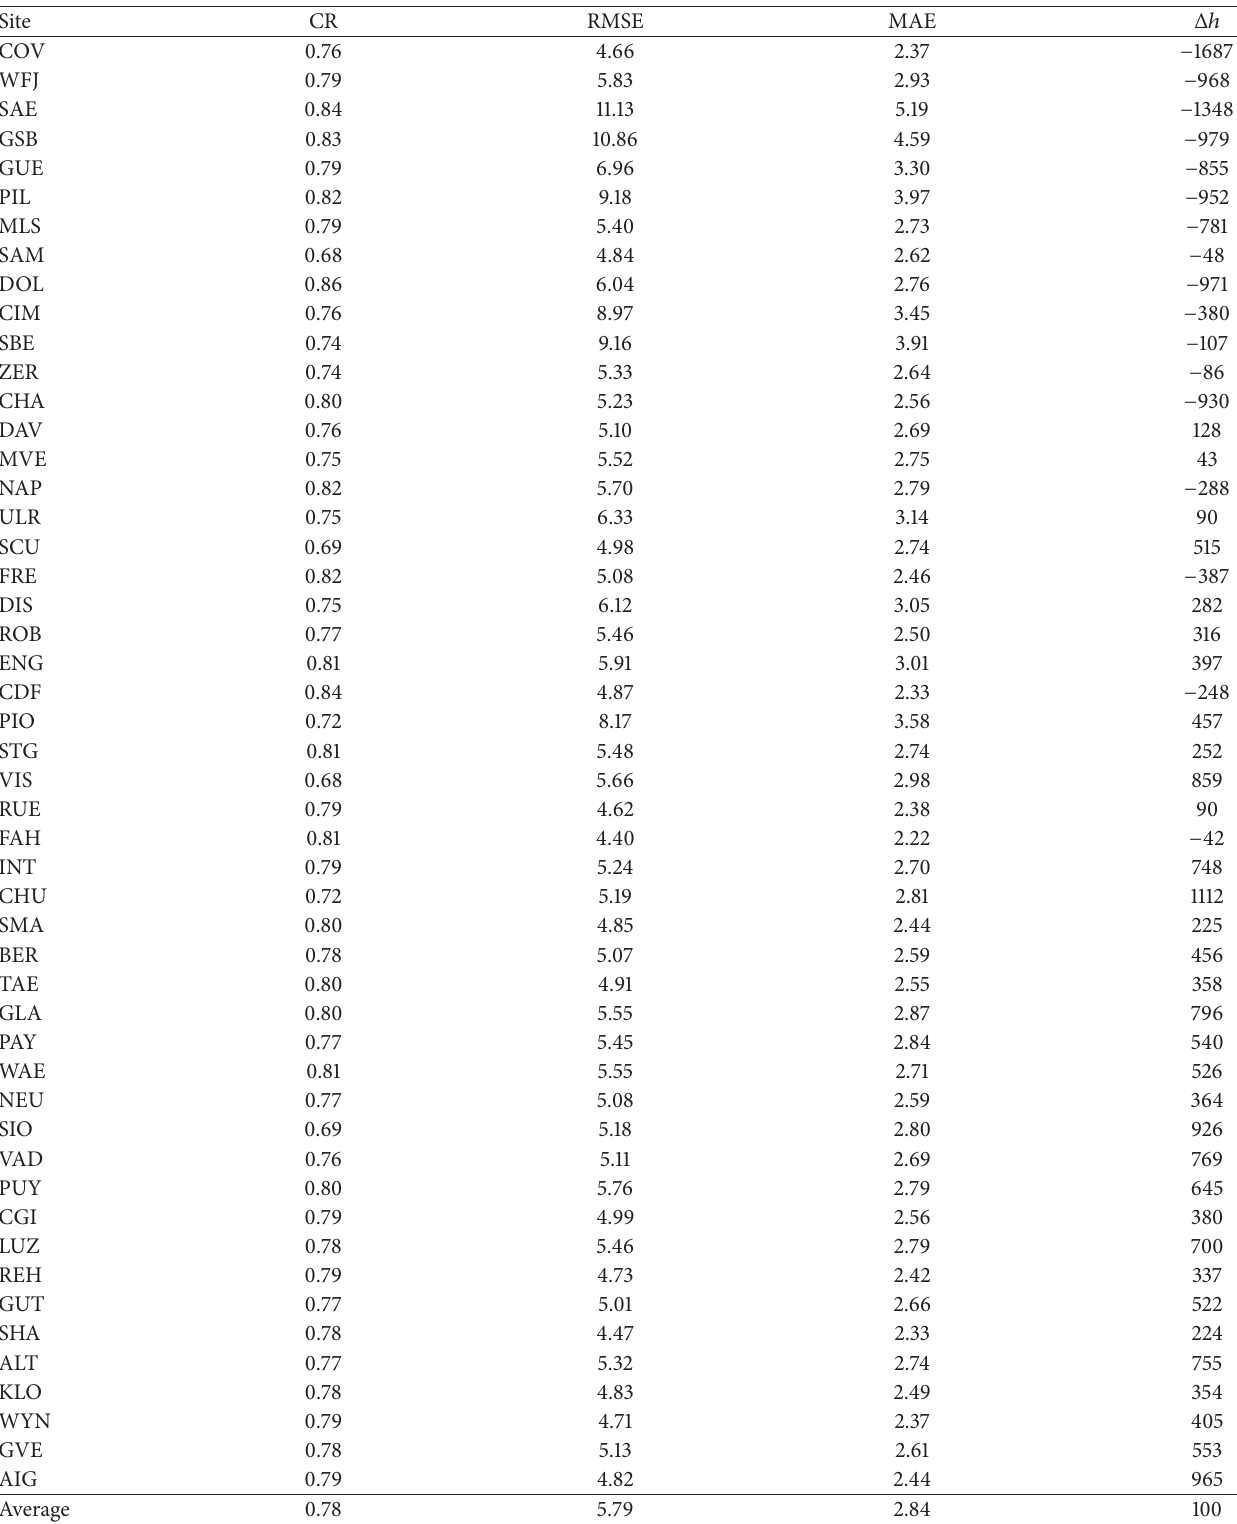
Table 3: Comparison of ERA-Interim forecast daily precipitation with observations at 50 meteorological stations from 1983 to 2010. CR, RMSE, and MAE in mm are listed. The elevations of sites are different with ERA-Interim grid heights, so the altitude differences ( Δℎ , ERA- Interim grid height minus elevation) are also